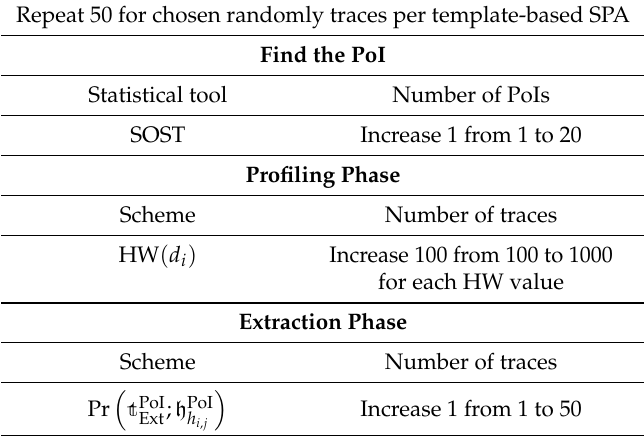
Table 2. Experimental variables for classical template-based SPA when loading plaintext in the block cipher AES with no countermeasure